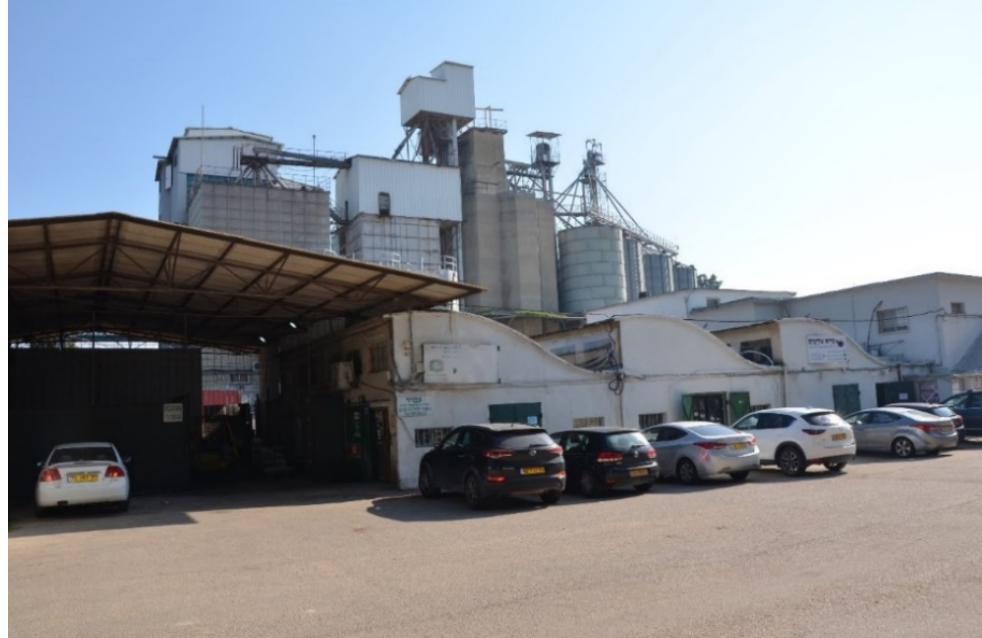
Figure 11. Infrastructure buildings in Nahalal that can be used for the regeneration of the rural center. Photo by the authors.